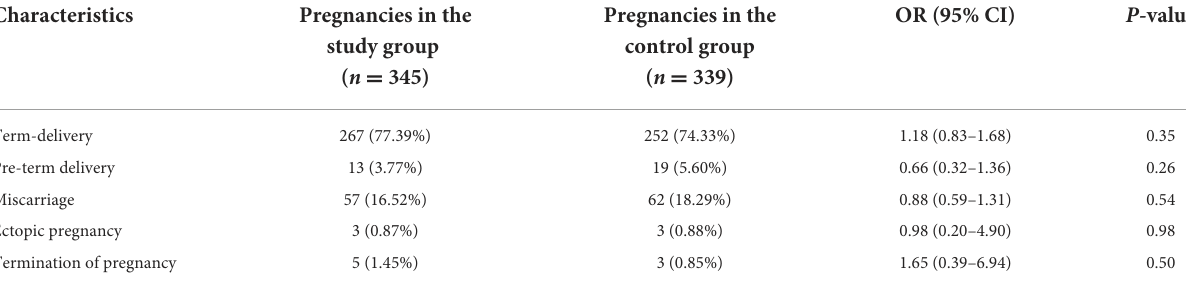
TABLE 2 Pregnancy outcomes following the index delivery for women following conservative treatment for placenta accreta spectrum vs. age-parity matched controls.